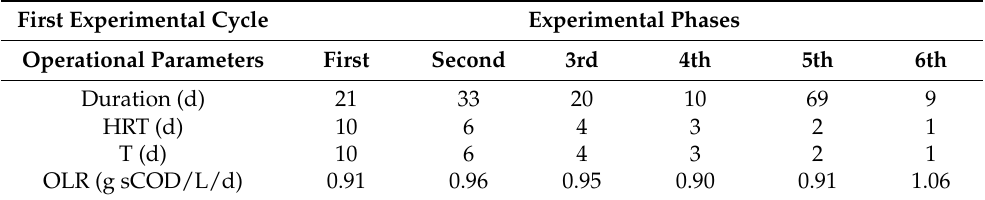
Table 1. Operational parameters imposed during the first experimental cycle. First Experimental Cycle